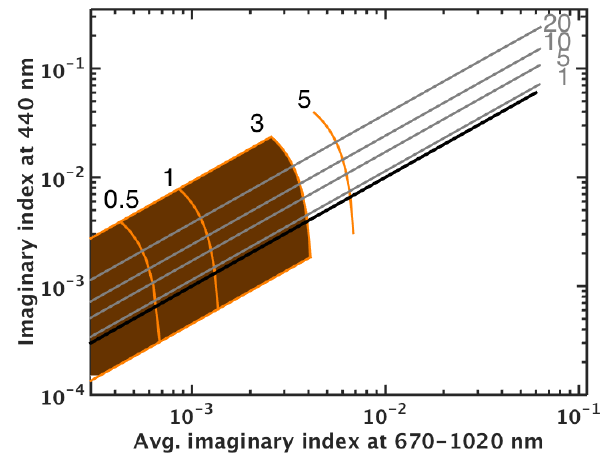
Figure 3. Theoretical imaginary refractive index space occupied by dust and carbonaceous aerosols. Shaded area indicates imaginary refractive indices at the AERONET wavelengths that are possible with mixtures of 0–3% free iron by volume in the form of hematite and/or goethite (as denoted by the labeled orange isolines). The bot- tom border of the shaded area represents a 0% hematite isoline, and the top border represents a 0% goethite isoline. The x axis is an average for the 670, 870, and 1020nm wavelengths ( k rnir ). Solid black line presents spectrally invariant refractive index, as expected for soot carbon (sC). Solid grey lines indicate BrC / sC mass mixing ratios of 1, 5, 10, and 20 when no absorbing dust is